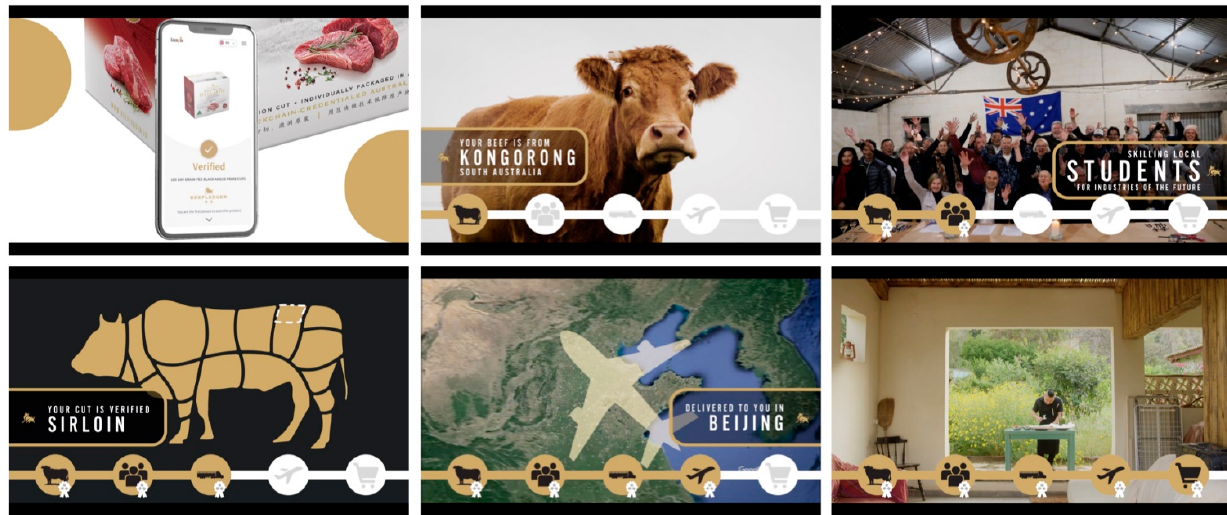
Figure 1. Six screenshots of the one-minute video showing from top left to bottom right: QR code scanning feature; visuals of food provenance and the region of origin in South Australia; visuals of the producer communities including high school students; illustration of the relevant cuts of beef; track and trace of the product’s routing from Australia to China; visuals of food preparation by consumers in China. Source: Authors. For web links to video see Appendix A.